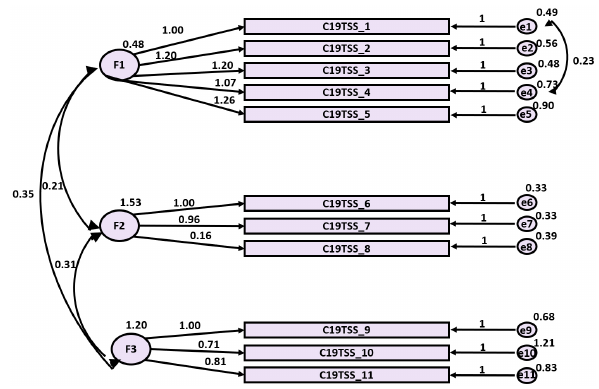
Fig. 1. CFA Results for Model 1 of the Portuguese version of C19TSS . Model fit indices: χ 2 /df: 1.968; RMSEA: 0.066; CI 90% LL; HL: 0.044; 0.088; p : 0.103; CFI: 0.957; TLI: 0.941; SRMR: 0.061.